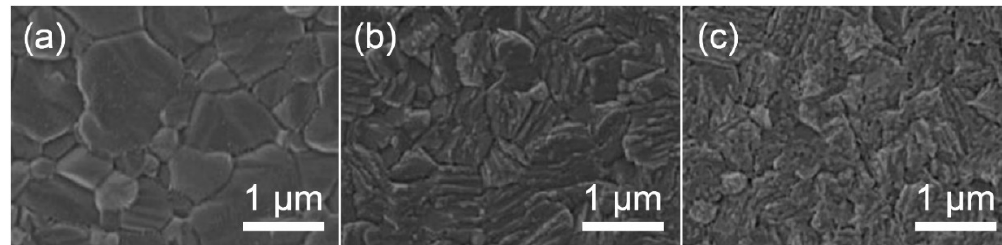
Figure 5. Morphology change when increasing the exposure time to vapor. SEM images of as-prepared ( a ) 3D perovskite film and the films with butyl ammonium iodide (BAI) vapor treatment for ( b ) 5 and ( c ) 60 min. Reprinted with permission from Ref. [46] Copyright 2019 Elsevier Ltd.